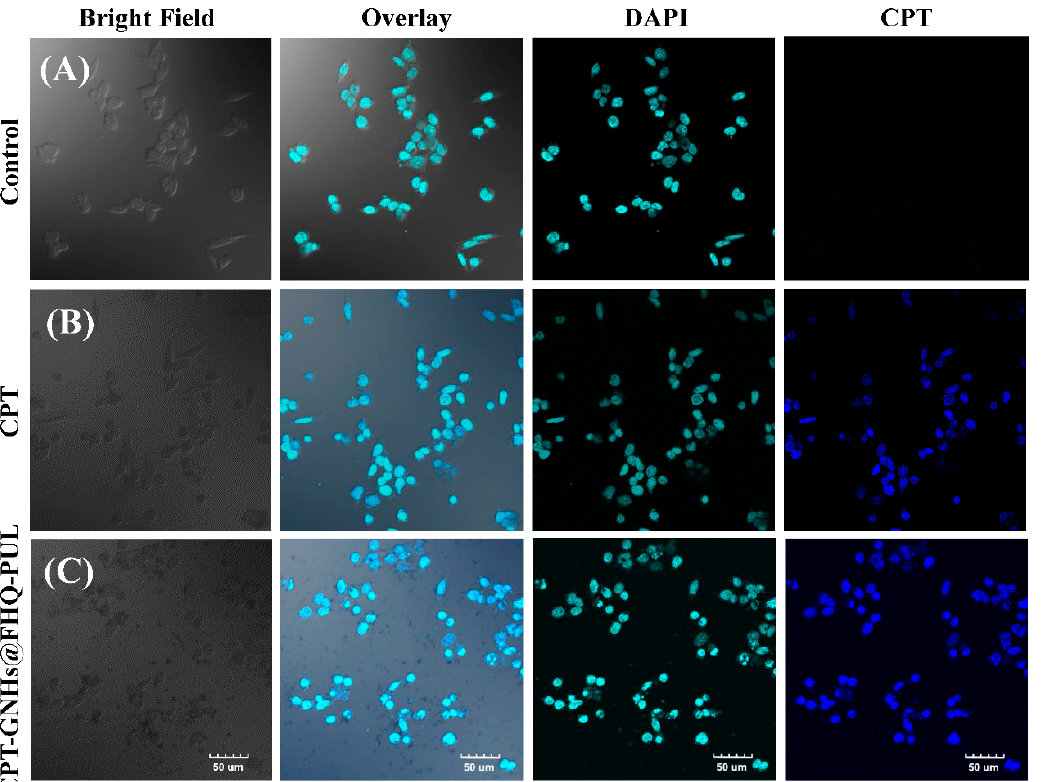
Figure 7. Confocal laser scanning microscopy images of Chago-k1 cells after incubation with ( A ) control, ( B ) CPT, and ( C ) CPT-GNHs@FHQ-PUL at 37 °C for 12 h.